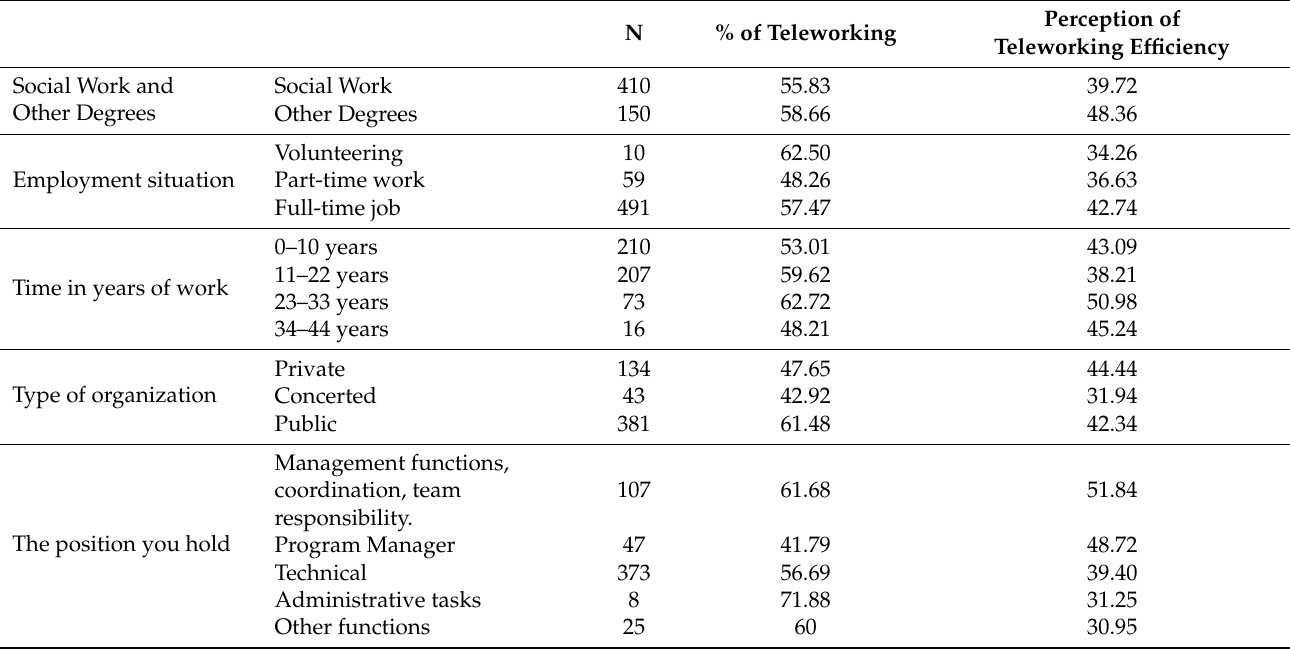
Table 4. Profile of the employment situation.